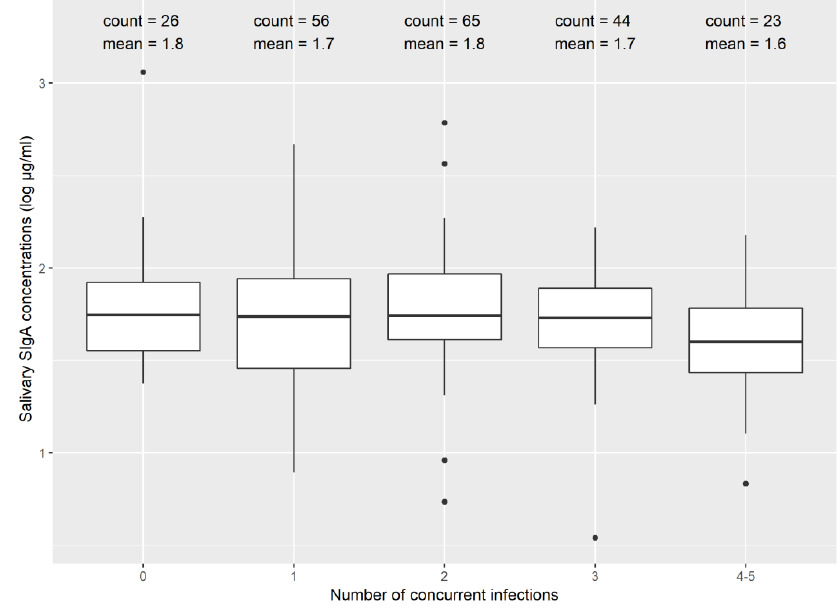
Figure 2. Salivary SIgA concentrations stratified by children experiencing di ff erent numbers of concurrent infections.